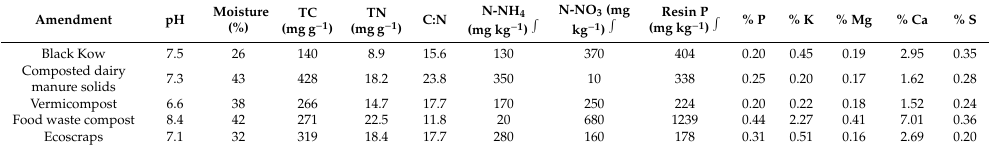
Table 2. Properties of raw amendments measured at the start of the study. All measurements were conducted on one sample, using dry amendments except those indicated as fresh amendments (